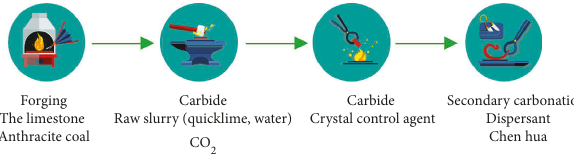
Figure 1: Application of calcium-based nanomaterials in the re- inforcement of art